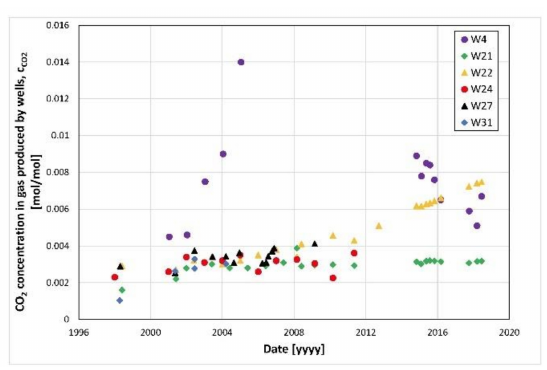
Figure 14. CO 2 concentration, C CO2 , in gas produced by wells: W4, W21, W22, W24, W27, W31.